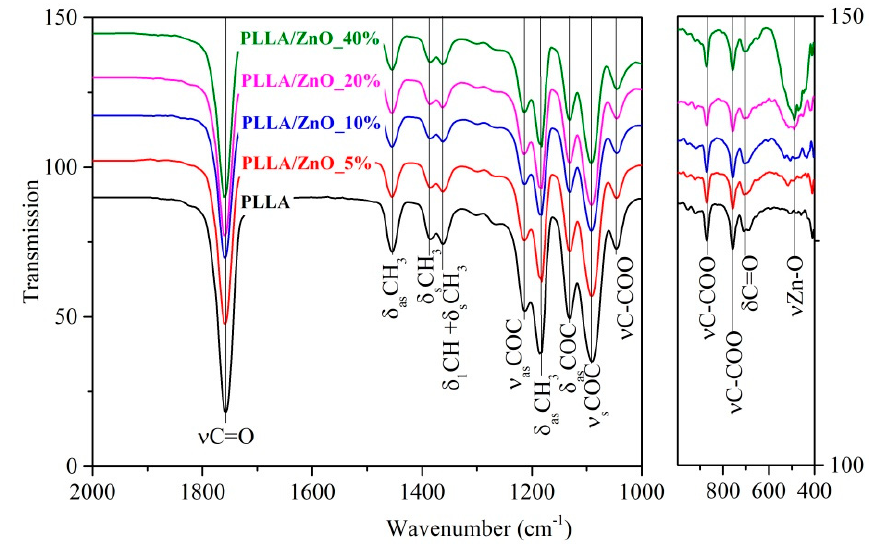
Figure 4. FTIR spectra of PLLA and ZnO-loaded PLLA membranes.